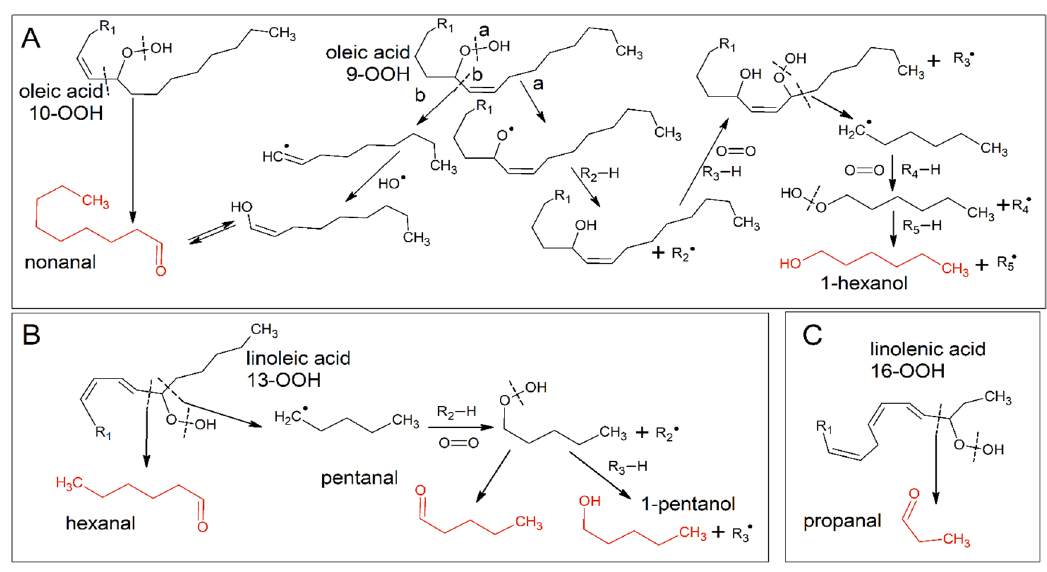
Figure 4. Formation pathways of the volatile compounds (in red) monitored during accelerated oxidation of O/W emulsions. ( A ) Oleic acid-derived compounds; ( B ) linoleic acid-derived compounds; ( C ) linolenic acid-derived compounds.